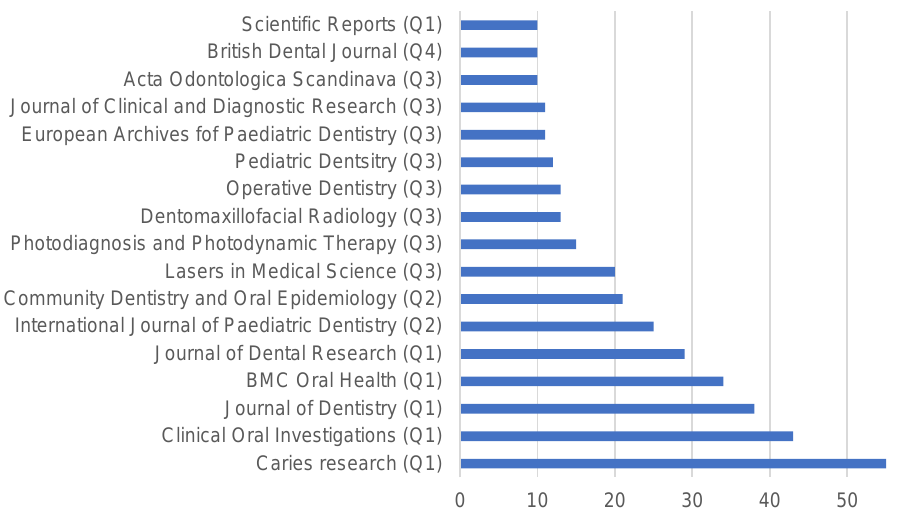
Table 1. Assessed methods for caries diagnosis.